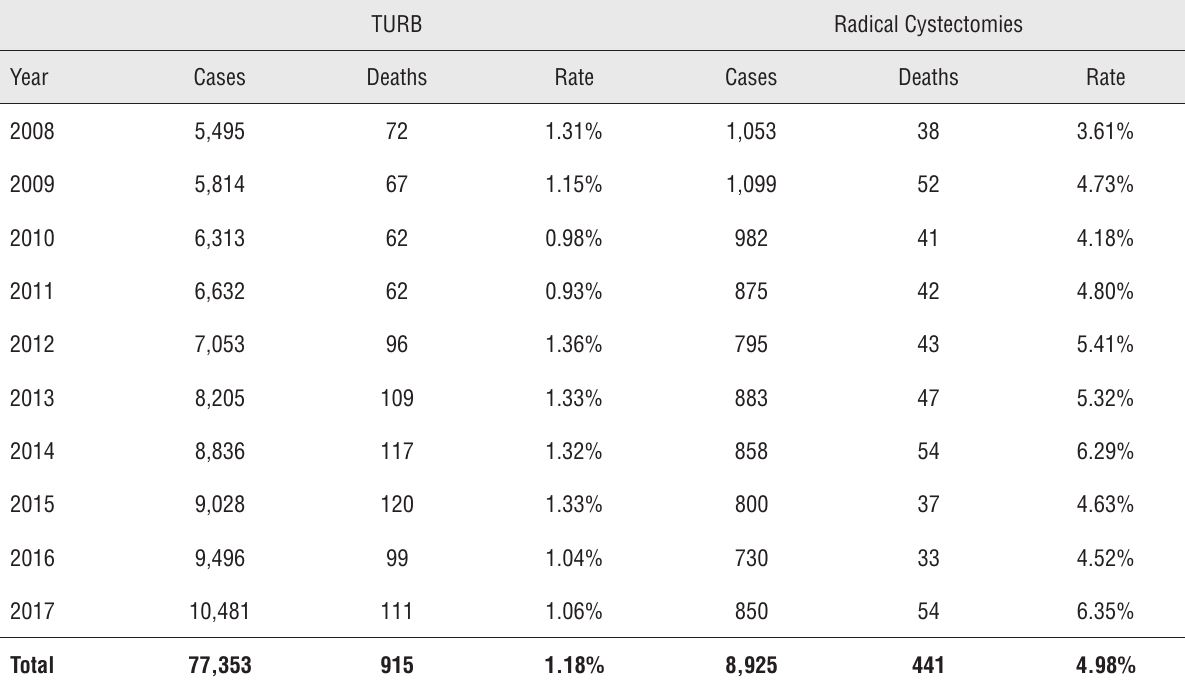
Table 2 - Endoscopic vs Open Procedures and related Death rates.